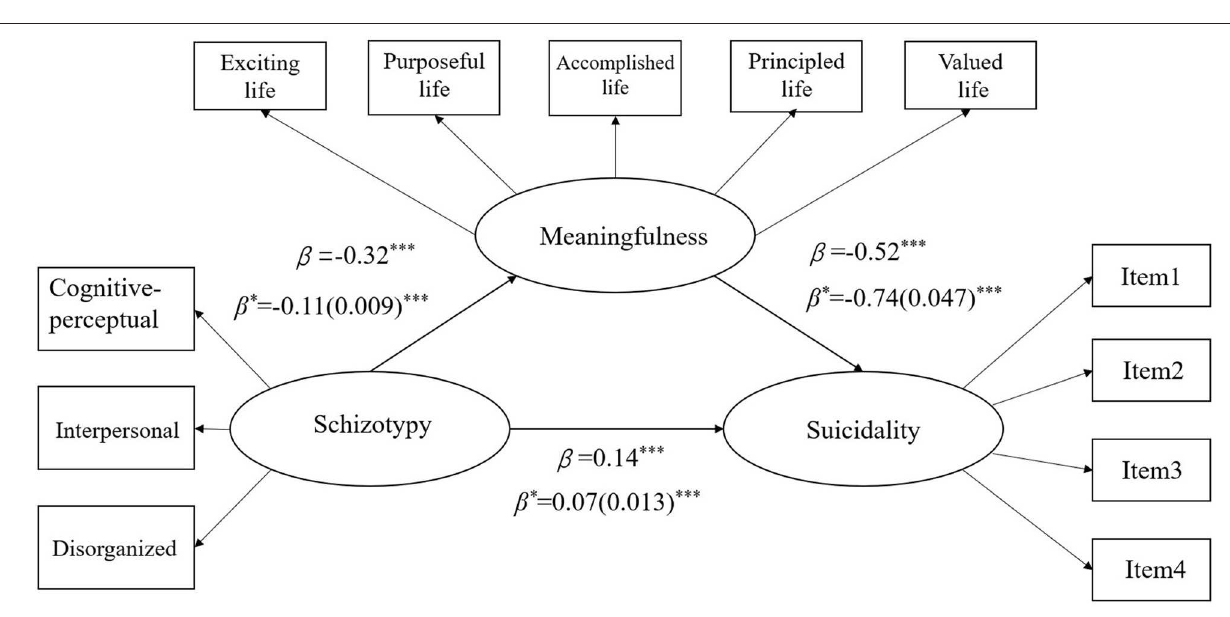
(see Table 4 ), χ ² = 282.95, df = 86, IFI = 0.99, CFI =